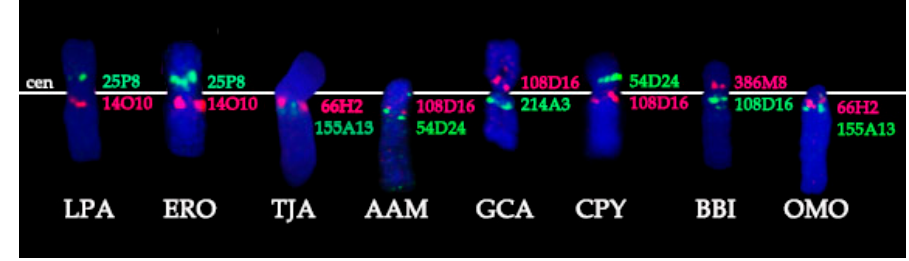
Figure 1. Centromere location (cen, white line) and positions of specific BAC clones (pink and green) on X chromosome of several cetartiodactyl species. Species three-letter codes are listed in Table 1. Taken together, we found that inversions (paracentric and pericentric) and centromere shifts were key rearrangements in the course of X chromosome evolution in Cetartiodactyla. In addition to the described rearrangements, the nucleolar organizing region (containing clusters of 18S and 28S rDNA genes) were localized on the short arm of both X and Y sex chromosomes of the Java mouse-deer (TJA) [33].